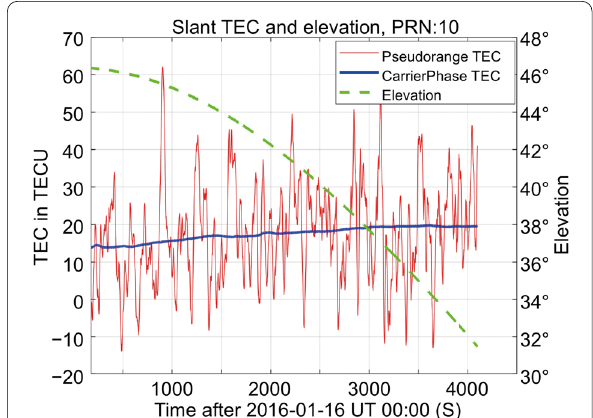
Fig. 3 Smoothing pseudorange TEC using carrier-phase TEC. The blue line is the “fitted relative slant